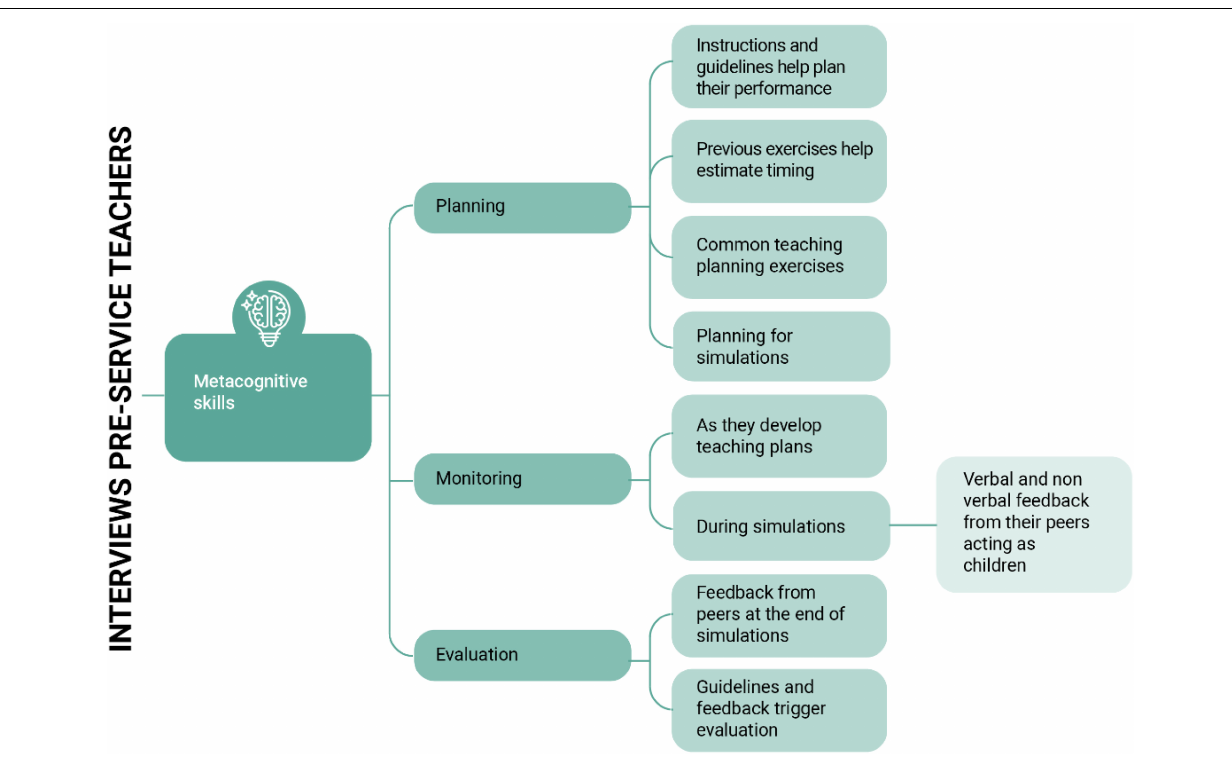
FIGURE 7 | Development of metacognitive skills in the assessment tasks. Synthesis of findings in the interviews with the pre-service